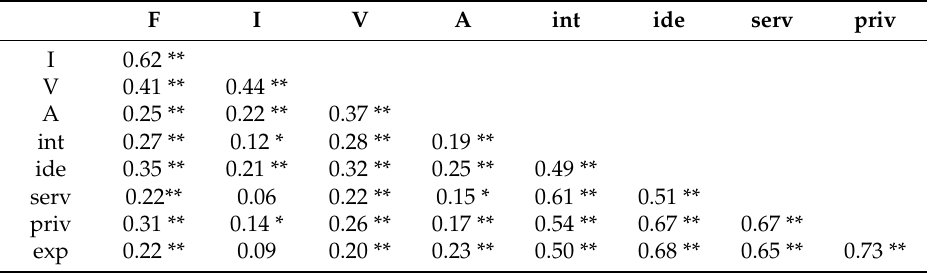
Table 10. Correlations among psycholinguistic features in religious words and each dimension of